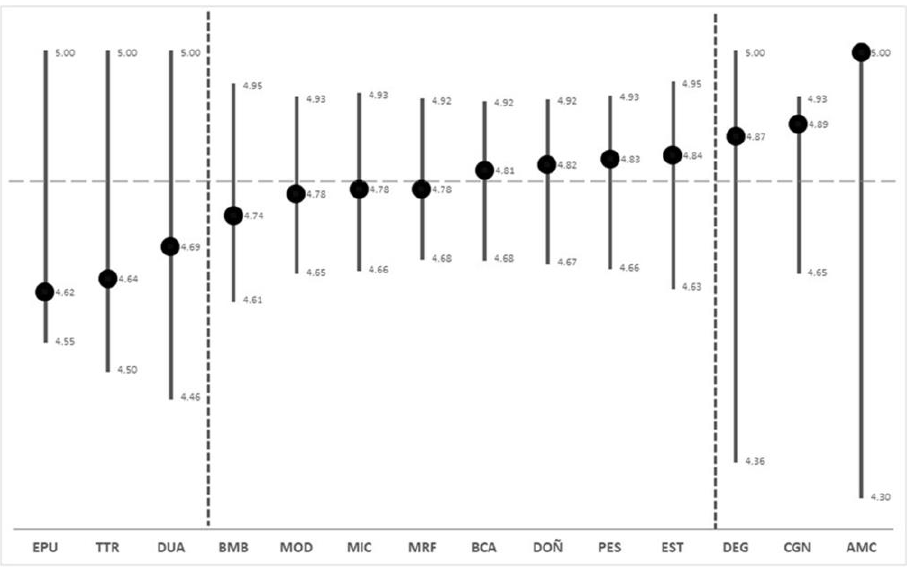
Figure 1. STD values (points) and the predicted interval between the maximum and minimum range (vertical lines) for each PA. AMC, Acantilados de Maro-Cerro Gordo; BCA, Bahía de Cadiz; BMB, La Breña y Marismas del Barbate; CGN, Cabo de Gata-Níjar; DEG, Desembocadura del Guadalhorce; DOÑ, Doñana; DUA, Dunas de Artola; EPU, Enebrales de punta Umbría; EST, Estrecho; MIC, Marismas de Isla Cristina; MOD, Marismas del Odiel; MRF, Marismas del Río Piedras y Flecha del Rompido; PES, Punta Entinas-Sabinar; TTR, Tómbolo de Trafalgar.